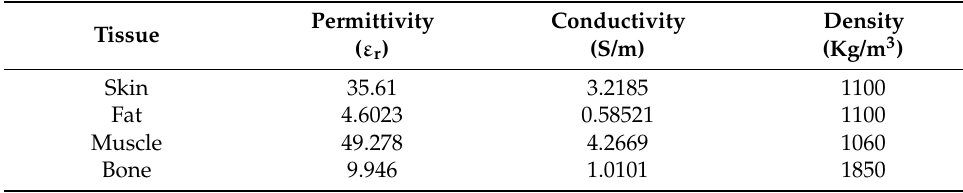
Table 4. Properties of human body